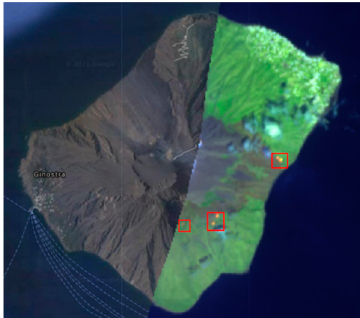
Figure 9. Fires detected at Stromboli after the 3 July 2019 paroxysm. False Color image made by B12-B11-B4 bands from Sentinel-2 MSI image acquired on 4 July 2019 at 09:49 UTC.